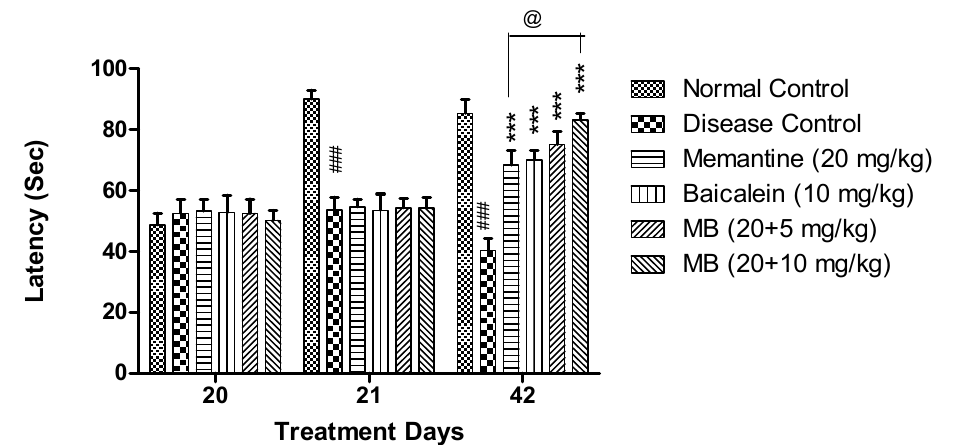
Figure 4. Passive Avoidance—The post shock latency of each treatment group was plotted against treatment days (20, 21 and 42 days). Data are shown as mean ± SEM (n = 6) at p < 0.05. Comparison with normal control is indicated with ### p < 0.001 whereas comparison with disease control is indicated with *** p < 0.001 and @ p < 0.05 indicate comparison with memantine treatment group. MB: memantine + baicalein.